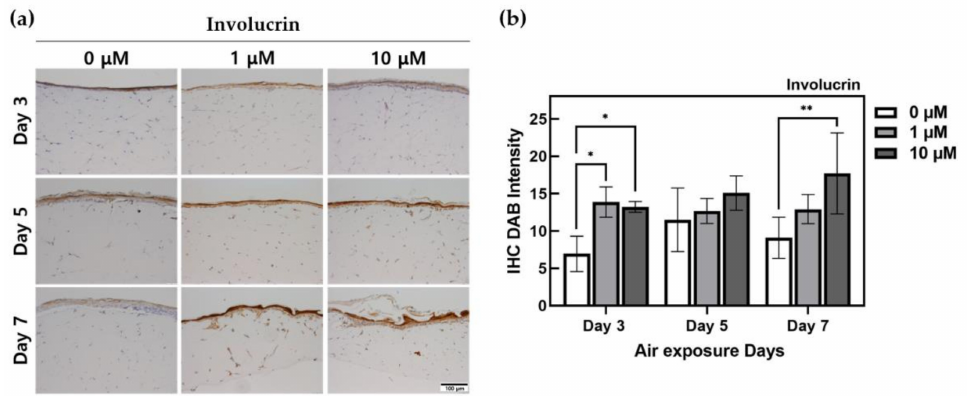
Figure 4. Immunohistochemistry-stained images for involucrin of HSEs treated α -lipoic acid concentration of 0, 1, and 10 µ M. ( a ) This is the result of involucrin expressed by IHC staining in HSEs. The x-axis is listed by ALA-treated concentration, and the y-axis is listed by ALA-treated period. The scale bar is 100 µ m. ( b ) This is a graph of quantification of DAB intensity for immunohistochemistry staining of involucrin protein using the ImageJ program. ( n = 4; *, p < 0.05; **, p < 0.01 vs. 0 µ M for each